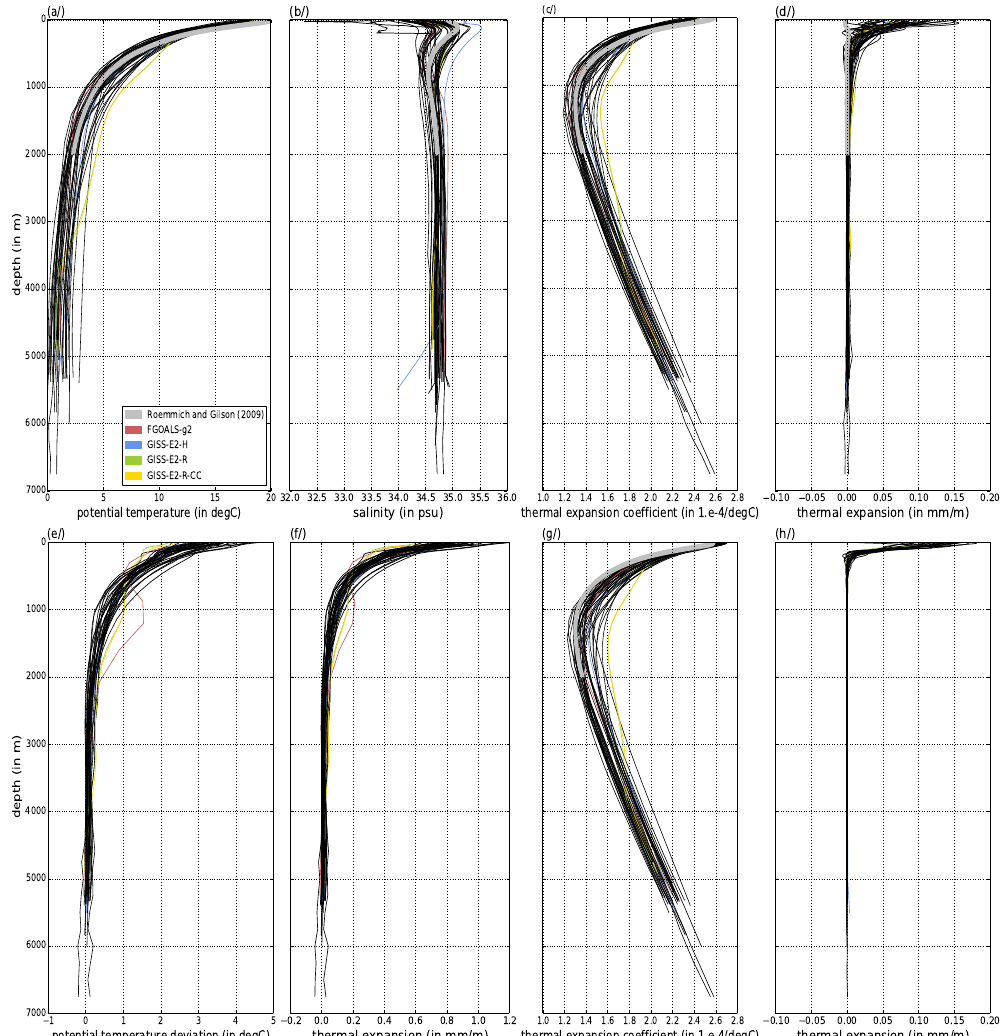
Figure 2. Global mean vertical profiles for all models of historical in year 1900 (upper panels, a – c ), historical in year 2005 relative to year 1986 (d) , rcp8.5 in year 2100 relative to the historical mean over 1986 to 2005 (lower panels, e – g ) and abrupt4xCO2 within the first year (h) : (a) potential temperature (in ◦ C, 0 to 20), (b) salinity (in PSS-78, 32 to 36) and (c) thermal expansion coefficient α (in 10 − 4 ◦ C − 1 , 1.2 to 2.8); (d) thermal expansion per layer (in mmm − 1 , − 0.1 to 0.2), (e) temperature deviation (in ◦ C, − 1 to 5), (f) thermal expansion per layer (in mmm − 1 , − 0.2 to 1.2) and (g) thermal expansion coefficient α (in 10 − 4 ◦ C − 1 , 1.0 to 2.8), (h) thermal expansion per layer (in mmm − 1 , − 0.2 to 1.2). Observed profiles (grey lines) are based on the Argo data as an average over the period 2005 to 2013, except for the thermal expansion in (d) . Model outliers are indicated in (a)